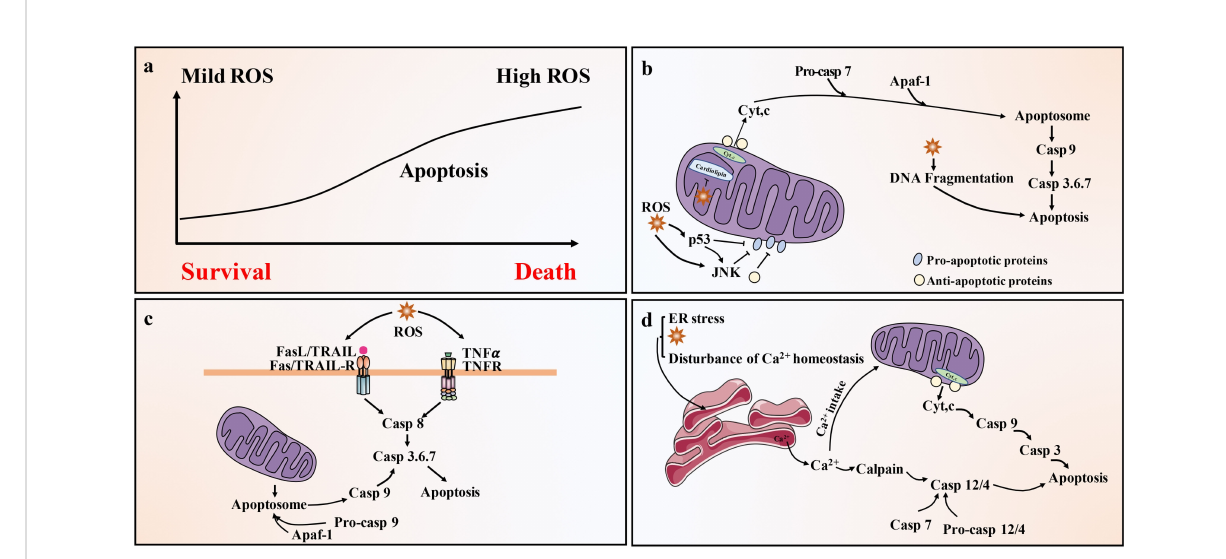
FIGURE 3 Pathways of ROS-driven apoptotic responses. (A) Low level of ROS (such as H2O2) is related to cell survival, but high level of ROS can activate cell death processes, such as apoptosis. (B) Activation of the mitochondrial (intrinsic) pathway of apoptosis by ROS. Exogenously or endogenously generated ROS can activate p53 and/or c-JNK, which activate pro-apoptotic Bcl-2 proteins and inhibit anti-apoptotic proteins. In addition, ROS cause mitochondrial damage membrane depolarization and/or opening of Bax/Bak channels on the outer mitochondrial membrane (OMM), allowing AIF, Endo G, Cyt c and Smac/Diablo to be released into the cytoplasm. Cyt c then forms apoptosome complex in the cytoplasm along with Apaf-1 and procaspase-9, leading to caspase 9 activation. Caspase 9 then activates effector caspase, such as caspase 3, ultimately causing apoptosis. (C) Activation of the death receptor (extrinsic) pathway of apoptosis by ROS. Death receptor-mediated apoptosis involves the recruitment of the bridging proteins FADD and procaspase-8 or -10 to the cytoplasmic surface of the receptor to form death- inducing signaling complex (DISC). This leads to the activation of caspase-8/-10, which can directly activate caspase-3/-6/-7 and trigger apoptosis. Caspase-8/-10 also cleaves Bid to produce tBid, which blocks the anti-apoptotic activity of Bcl-2 and Bcl-xl, and activates Bax and Bak. This leads to the release of Cyt c and Smac/Diablo and the activation of the mitochondrial pathway of apoptosis. (D) ROS activates the ER stress response and cause apoptosis through the ER. Ca 2+ released from the ER is taken up by the mitochondria, leading to depolarization of the inner mitochondrial membrane (IMM). ER caspase-4/-12 activation by calpain and possibly caspase-7 leads to activation of caspase-9 and caspase-3. Caspase-9 and 3 can be activated through mitochondria-dependent and independent